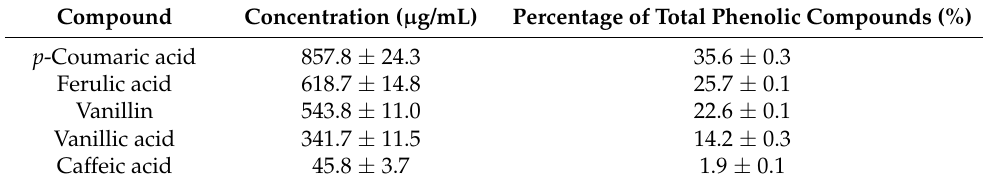
Table 4. Profile of phenolic compounds in ethanolic propolis